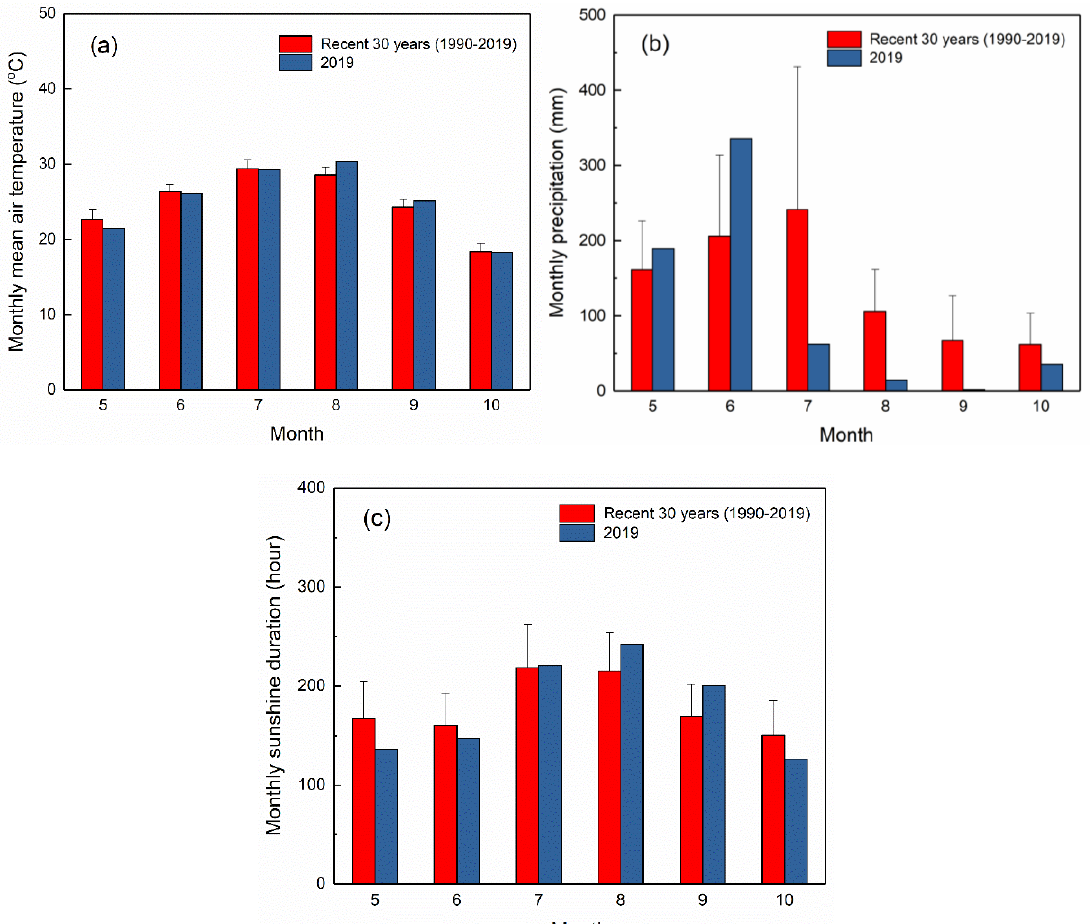
Figure 1. The monthly air temperature ( a ), precipitation ( b ), and sunshine duration ( c ) at the study area during the experimental year and the recent 30 years. The results of 1990–2019 are the averaged values of these years and are with vertical bars indicating standard deviations. Bars without standard deviations means there is no error or the error was near to zero.